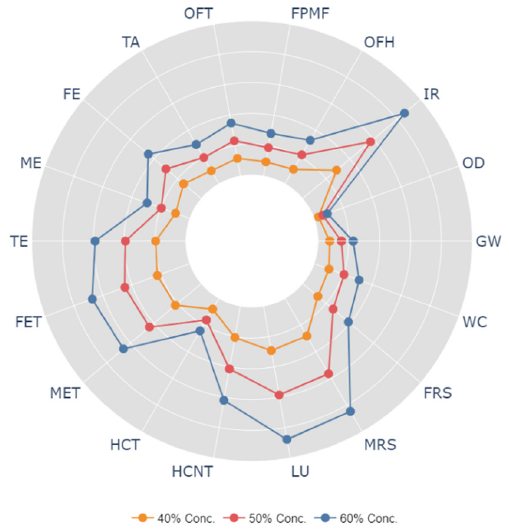
Figure 12. Sensitivity analysis for three different acetone concentrations. Here, GW is global warming, OD is stratospheric ozone depletion, IR is ionizing radiation, OFH is ozone formation, human health, FPMF is fine particulate matter formation, OFT is ozone formation, terrestrial ecosystems, TA is terrestrial acidification, FE is freshwater eutrophication, ME is marine eutrophication, TE is terrestrial ecotoxicity, FET is freshwater ecotoxicity, MET is marine ecotoxicity, HCT is human carcinogenic toxicity, HCNT is human non-carcinogenic toxicity, LU is land use, MRS is mineral resource scarcity, FRS is fossil resource scarcity, and WC is water consumption.